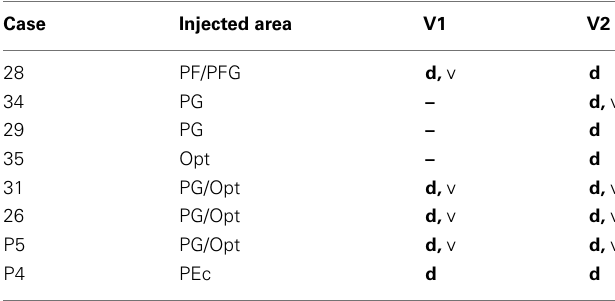
Table 2 | Presence and dorsal/ventral location in the CF of the labeling inV1